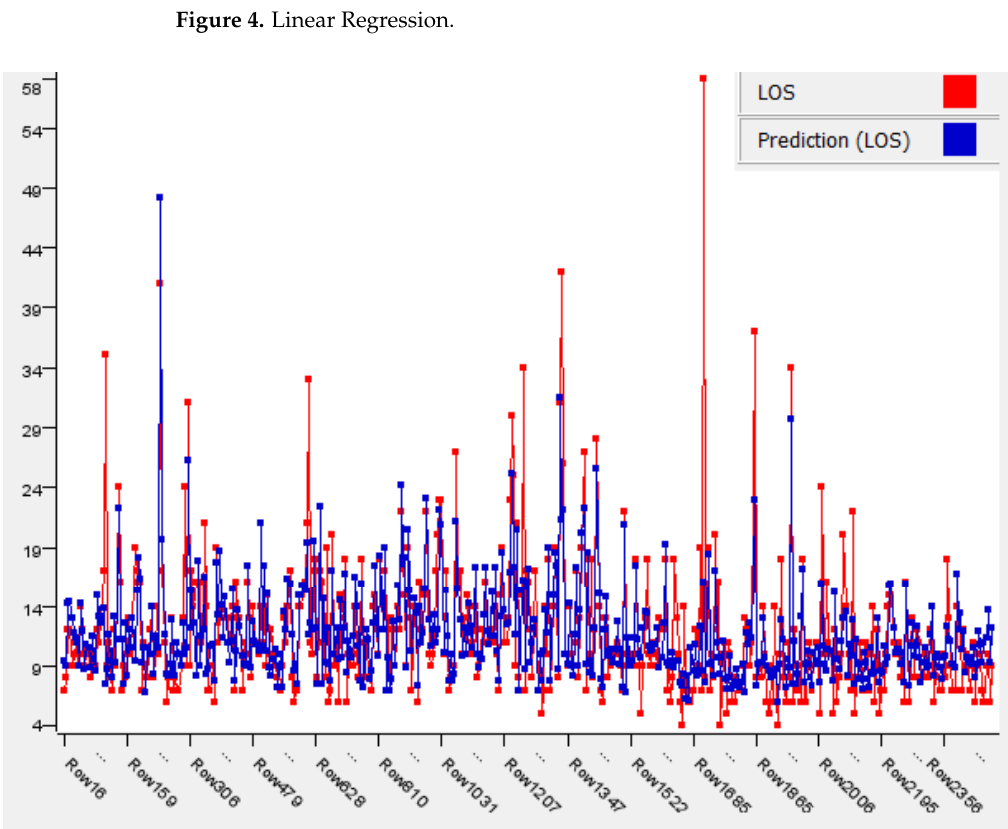
Figure 5. XGBoost. Figure 5.